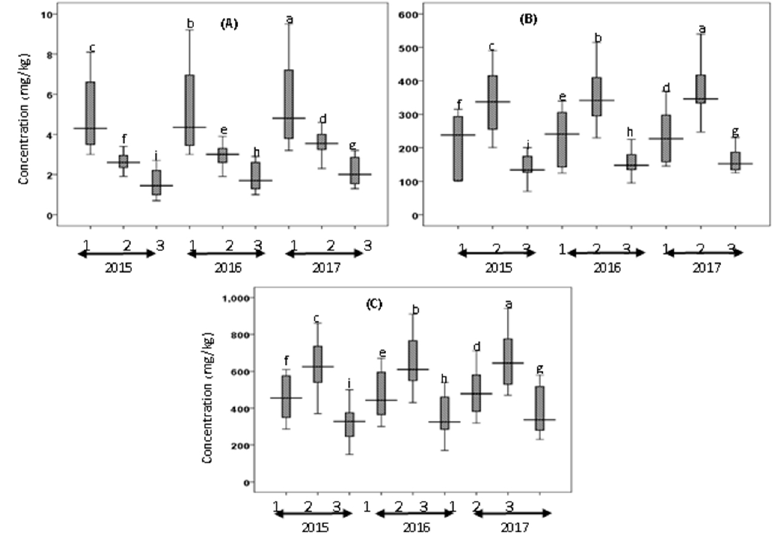
Fig. 1. Boxplot of Cd (A), Pb (B), and Zn (C) in study area. 1, 2 and 3 represent the stations concerned in this